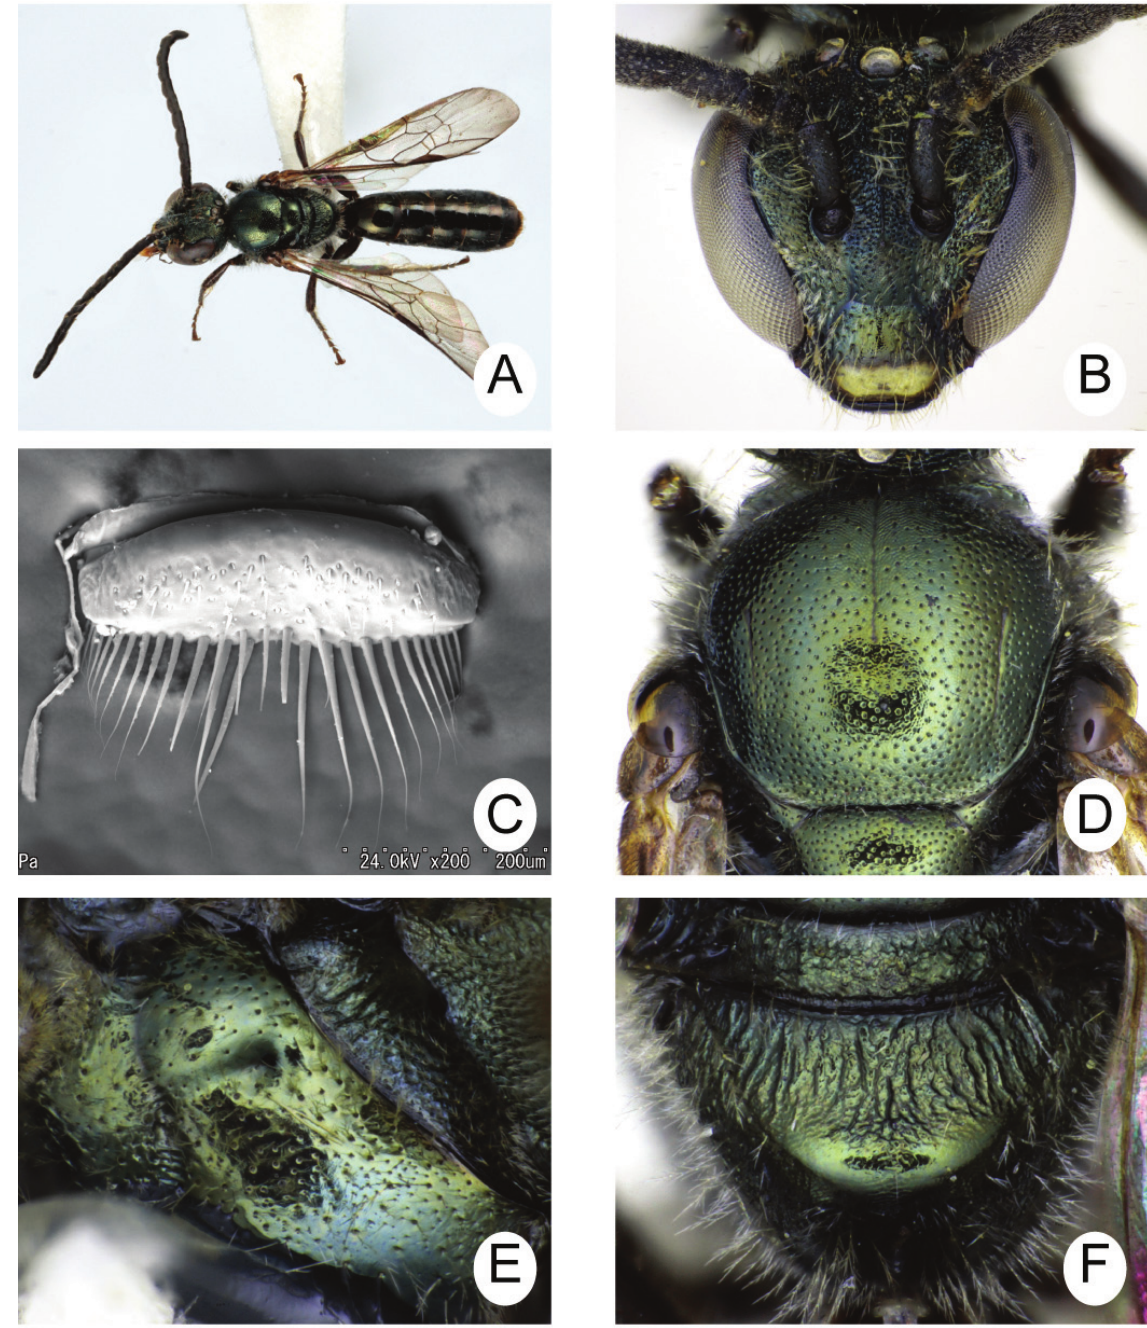
Fig. 6. Lasioglossum ( Dialictus ) atroglaucum (Strand, 1913), ♂. A . General habitus. B . head in frontal view. C . Labrum. D . Mesoscutum. E . Mesepisternum. F .